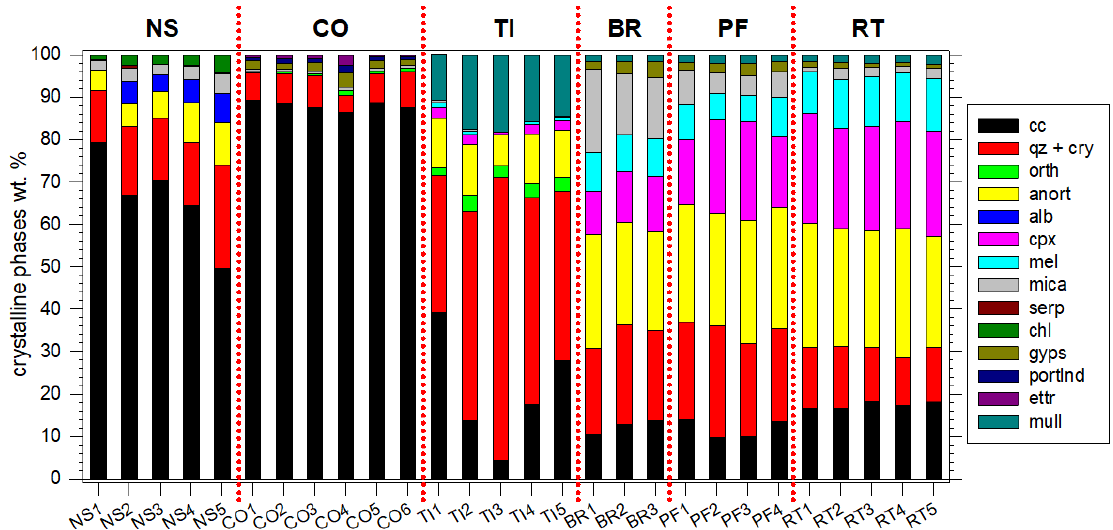
Figure 7. QPA-Rietveld abundance of crystalline phases in the six groups of RAs from CDW rubbles. The acronyms of crystalline phases are reported in Table 3 .